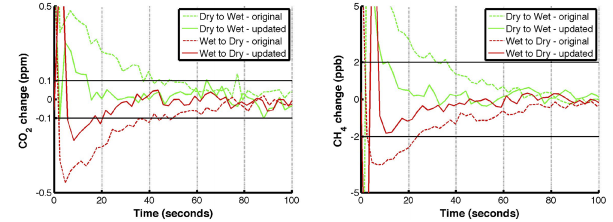
Fig. 5. Transition times from wet to dry gas (red) and from dry to wet (green) before (dashed lines) and after (solid lines) the ana- lyzer software parameter change that controls the baseline response time. CO 2 is shown in the left panel and CH 4 on the right. The WMO-recommended compatibility of measurements is shown in solid black lines: 0.1ppm for CO 2 and 2ppb for CH 4 .